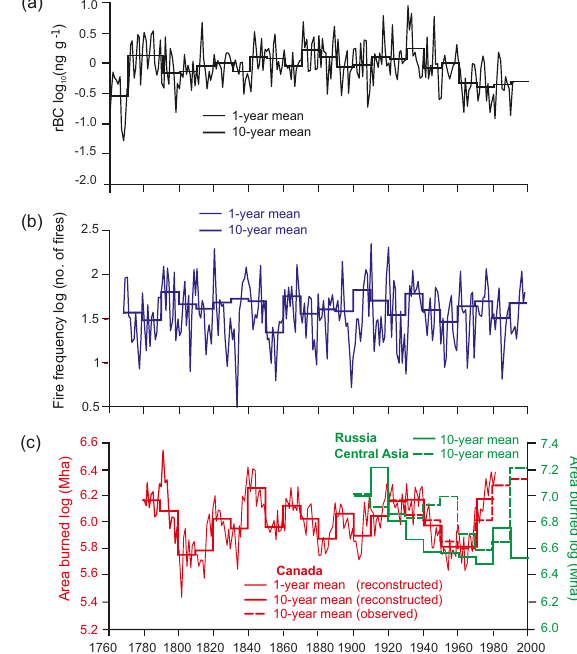
Figure 9. (a) Historical variations in rBC concentration in the DV99.1 core, 1760–1992, compared with reconstructed historical trends in (b) fire frequency in the eastern boreal forest region of Canada (Girardin et al., 2006), and (c) burned area across northern Canada (Girardin, 2007) and in the boreal and grassland regions of Russia and central Asia (Mouillot and Field, 2005). All data were log-transformed to facilitate visual